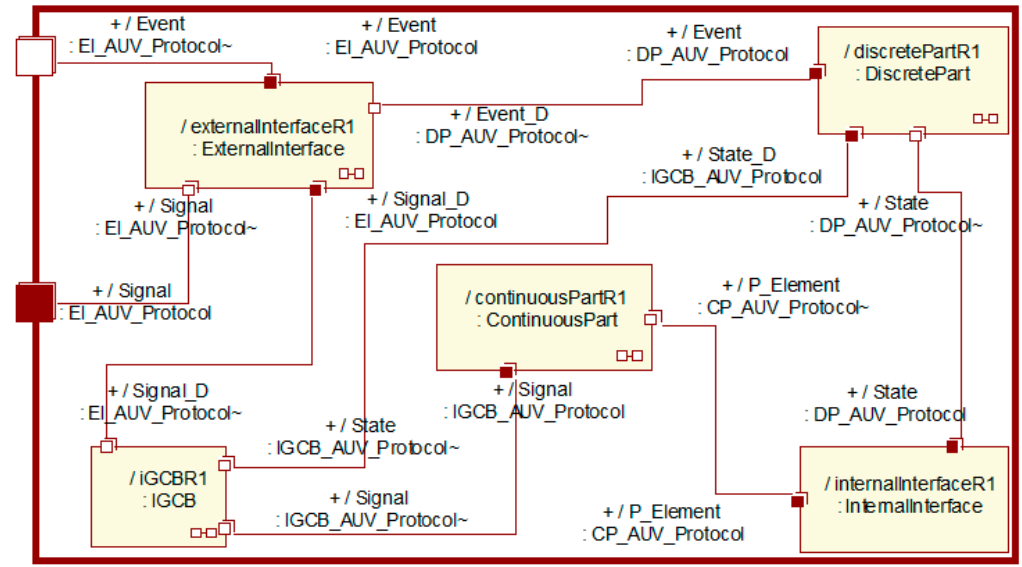
Figure 5. Collaboration diagram of real-time capsules for an AUV controller (data from [63]).